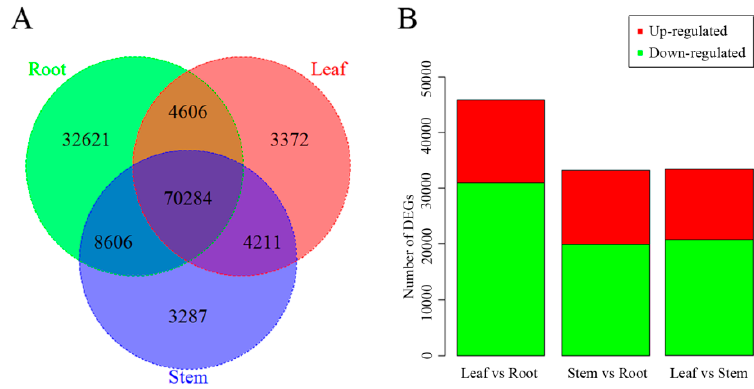
Figure 5. Expression of unigenes in C. chinense leaf, stem and root tissues. ( A ) Venn diagram of the number of unigenes expressed in stem, leaf and root tissues. ( B ) Number of upregulated and downregulated DEGs in leaf vs. root, stem vs. root and leaf vs. stem datasets.